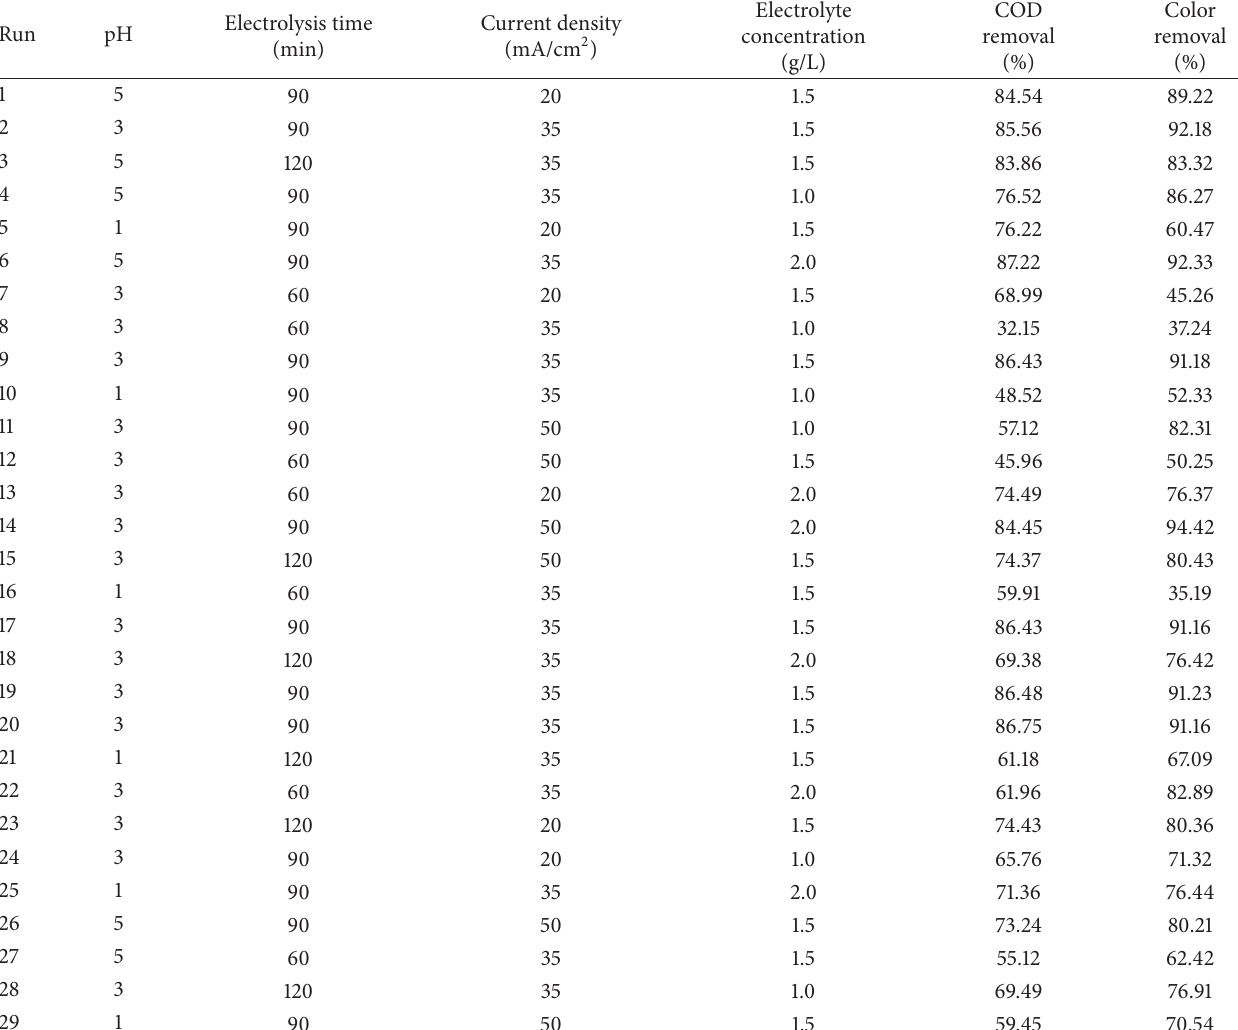
Table 3: Experimental design, observed yields in BBD experiments in terms of percentage removal of COD and